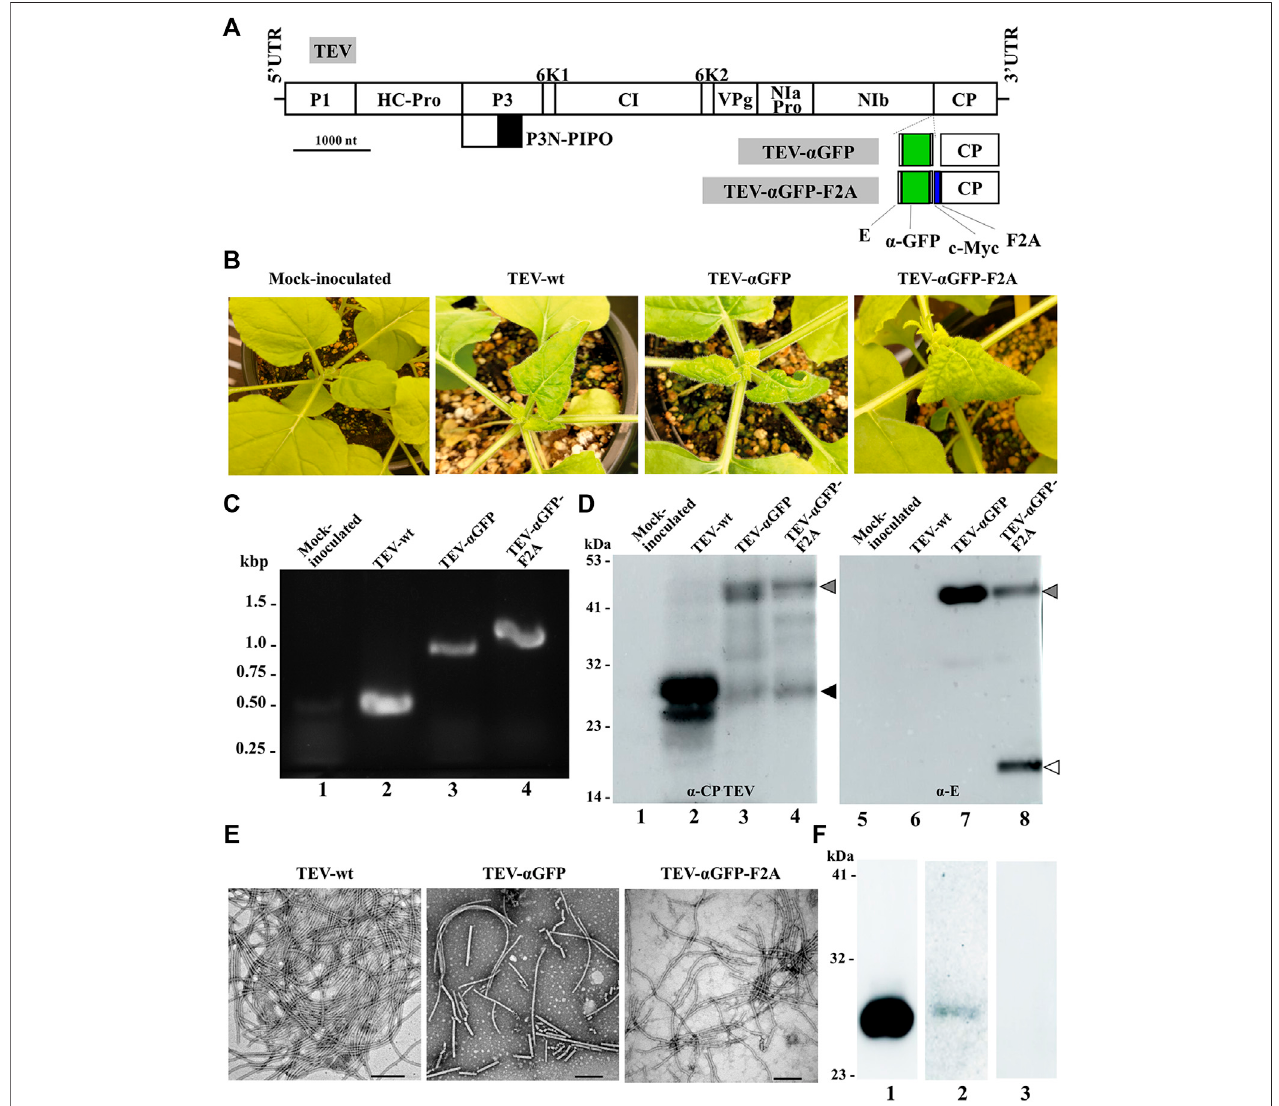
FIGURE 5 | Production of TEV-derived nanoparticles decorated with a nanobody in biofactory plants. (A) Schematic representation of the TEV genome indicating the position where a heterologous sequence coding for an α GFP fl anked with E and c-Myc epitopes was inserted with or without the picornavirus F2A peptide. Lines represent the TEV 5 ′ and 3 ′ UTRs; boxes represent the P1, HC-Pro, P3, P3N-PIPO, 6K1, CI, 6K2, VPg, NIaPro, NIb, and CP cistrons, as indicated. Scale bar corresponds to 1000 nt. (B) Pictures of representative upper leaves from N. benthamiana plants agroinoculated with TEV-wt, TEV- α GFP, and TEV- α GFP-F2A, as indicated, taken at 14 dpi. (C) RT-PCR analysis of the progeny of recombinant TEV inoculated into N. benthamiana plants. Representative samples from triplicate- inoculated plants are shown. Ampli fi cation products around the TEV CP region were separated by electrophoresis in an agarose gel, which was stained with ethidium bromide. DNA marker ladder with sizes (in kbp) on the left; lane 1, mock-inoculated plant; lanes 2 to 4, plants agroinoculated with TEV-wt, TEV- α GFP, and TEV- α GFP- F2A, respectively. (D) Westernblot analysesofprotein extracts using antibodies against TEV CP(left panel) and theE epitope fused to the α GFP nanobody (right panel). Proteins were separated by SDS-PAGE and transferred to a membrane. Lane 1 and 5, mock-inoculated plant; lanes 2 and 6, plant agroinoculated with TEV-wt; lanes 3 and 7, plant agroinoculated with TEV- α GFP; lanes 4 and 8, plant agroinoculated with TEV- α GFP-F2A. The positions and sizes of protein standards are indicated on the left. Arrowheads indicates the positions of TEV CP (black), free α GFP (white), and the α GFP-F2A-CP fusion (gray). (E) TEM micrographs of puri fi ed TEV-wt, TEV- α GFP, and TEV- α GFP-F2A virions, as indicated. Scale bar indicates 200 nm. (F) Assays to evaluate the antigen-binding capacity of the TEV-derived VNP, with nanobodies against GFP by western blot. GFP was separated by SDS-PAGE by triplicate, and the proteins were transferred to a membrane. The fi rst lane was incubated with a commercial anti GFP antibody conjugated to HRP; the second lane was incubated with virion preparations from plants infected with TEV- α GFP-F2A and a secondary anti E-HRP; the third lane was incubated only with the anti E-HRP